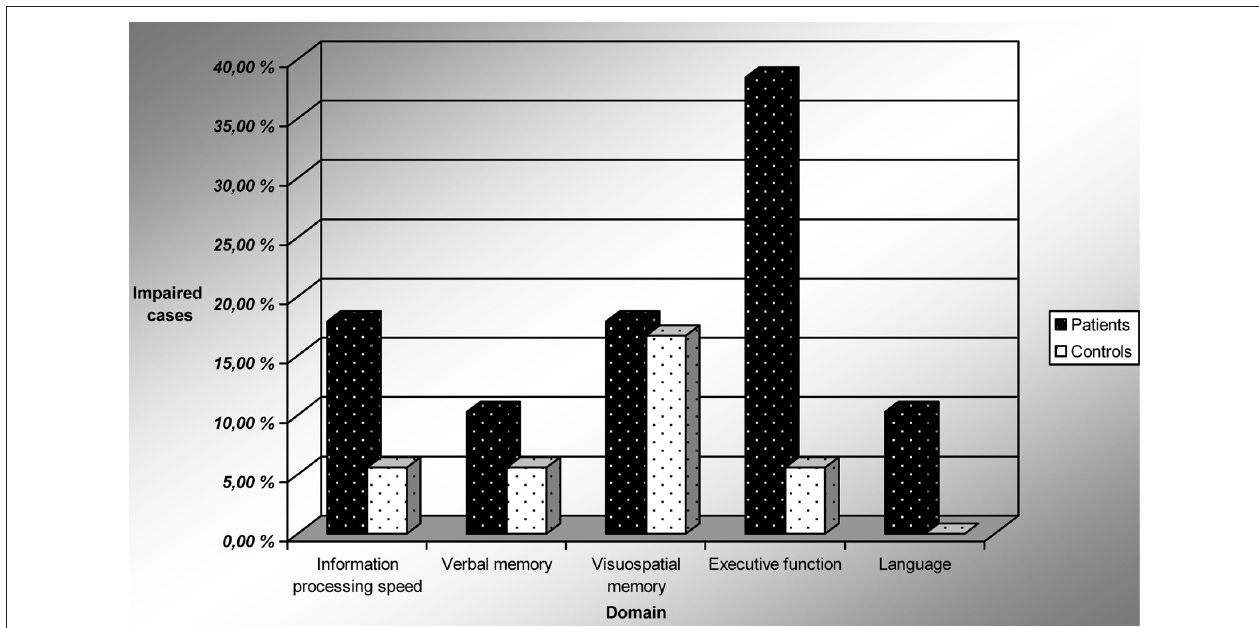
FIGURE 1 | Performance on cognitive domains by LLD patients and controls. Impairment is defined as performance below the 10th percentile of the control subjects. Abbreviation: LLD, late life depression.